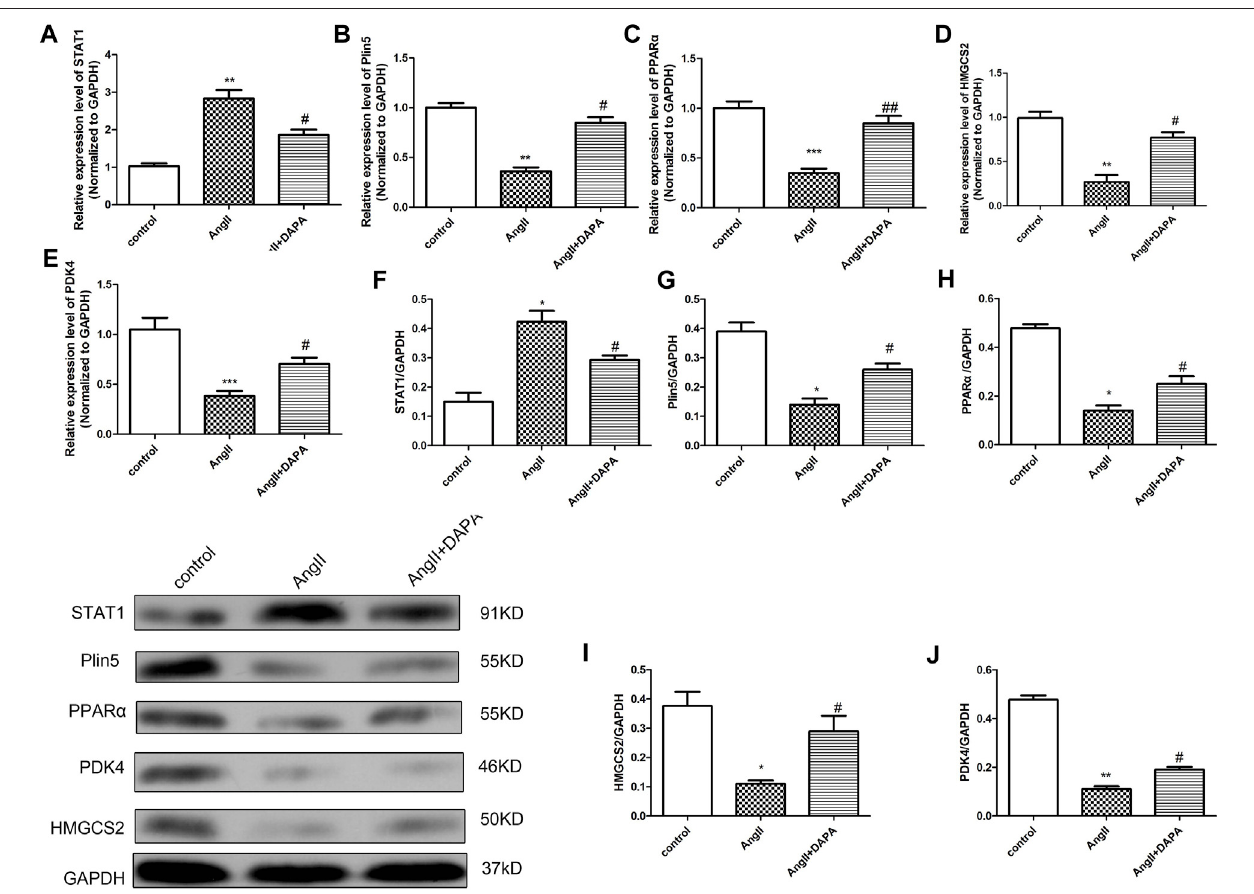
FIGURE 5 | Dapagli fl ozin mediated the Plin5/PPAR α signaling axis to mitigate AngII-induced cardiomyocyte hypertrophy. qRT-PCR analysis was used to detect the mRNA expressions of STAT1 (A) , Plin5 (B) , PPAR α (C) , HMGCS2 (D) and PDK4 (E) in cardiomyocytes of different groups. (F – J) Western blotting assay was performed todetect theprotein expressionsofSTAT1,Plin5, PPAR α ,HMGCS2and PDK4.The datawereexpressed asmean ± SD, n (cid:1) 3,* p < 0.05, vs. controlgroup; # p < 0.05, vs. AngII group.